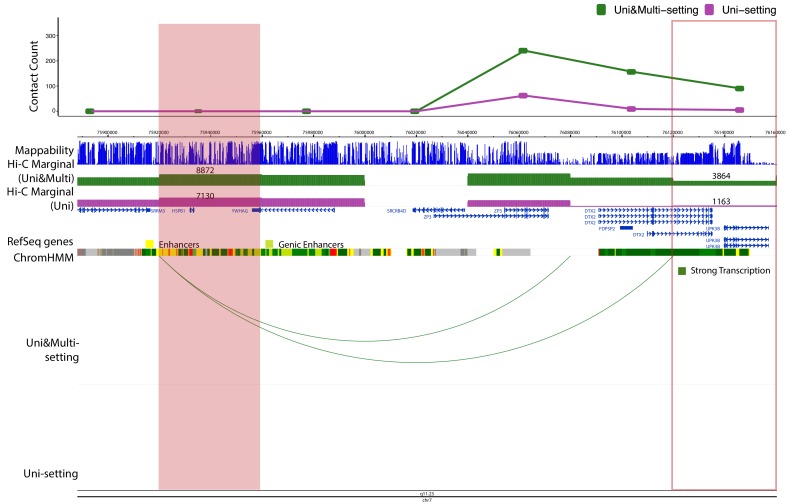
Examples of significant promoter-enhancer interactions reproducible among six replicates under Uni- and Uni&Multi-settings (IMR90) on chromosome 7.